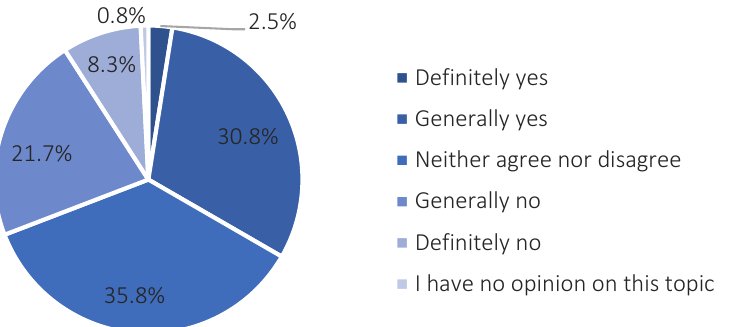
Figure 10. An assessment of the match between the term smart city and the city of Suwałki. Source: own study based on questionnaire surveys.